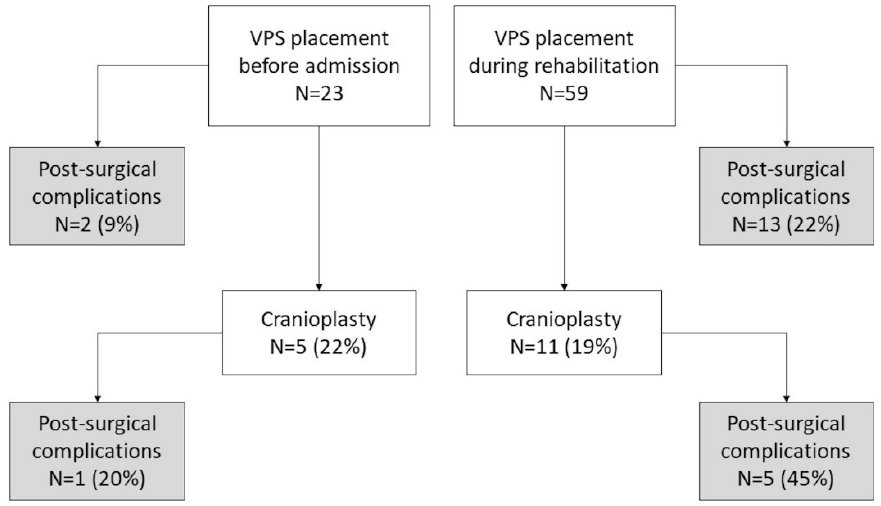
Figure 1. Study Figure 1. Study flowchart.